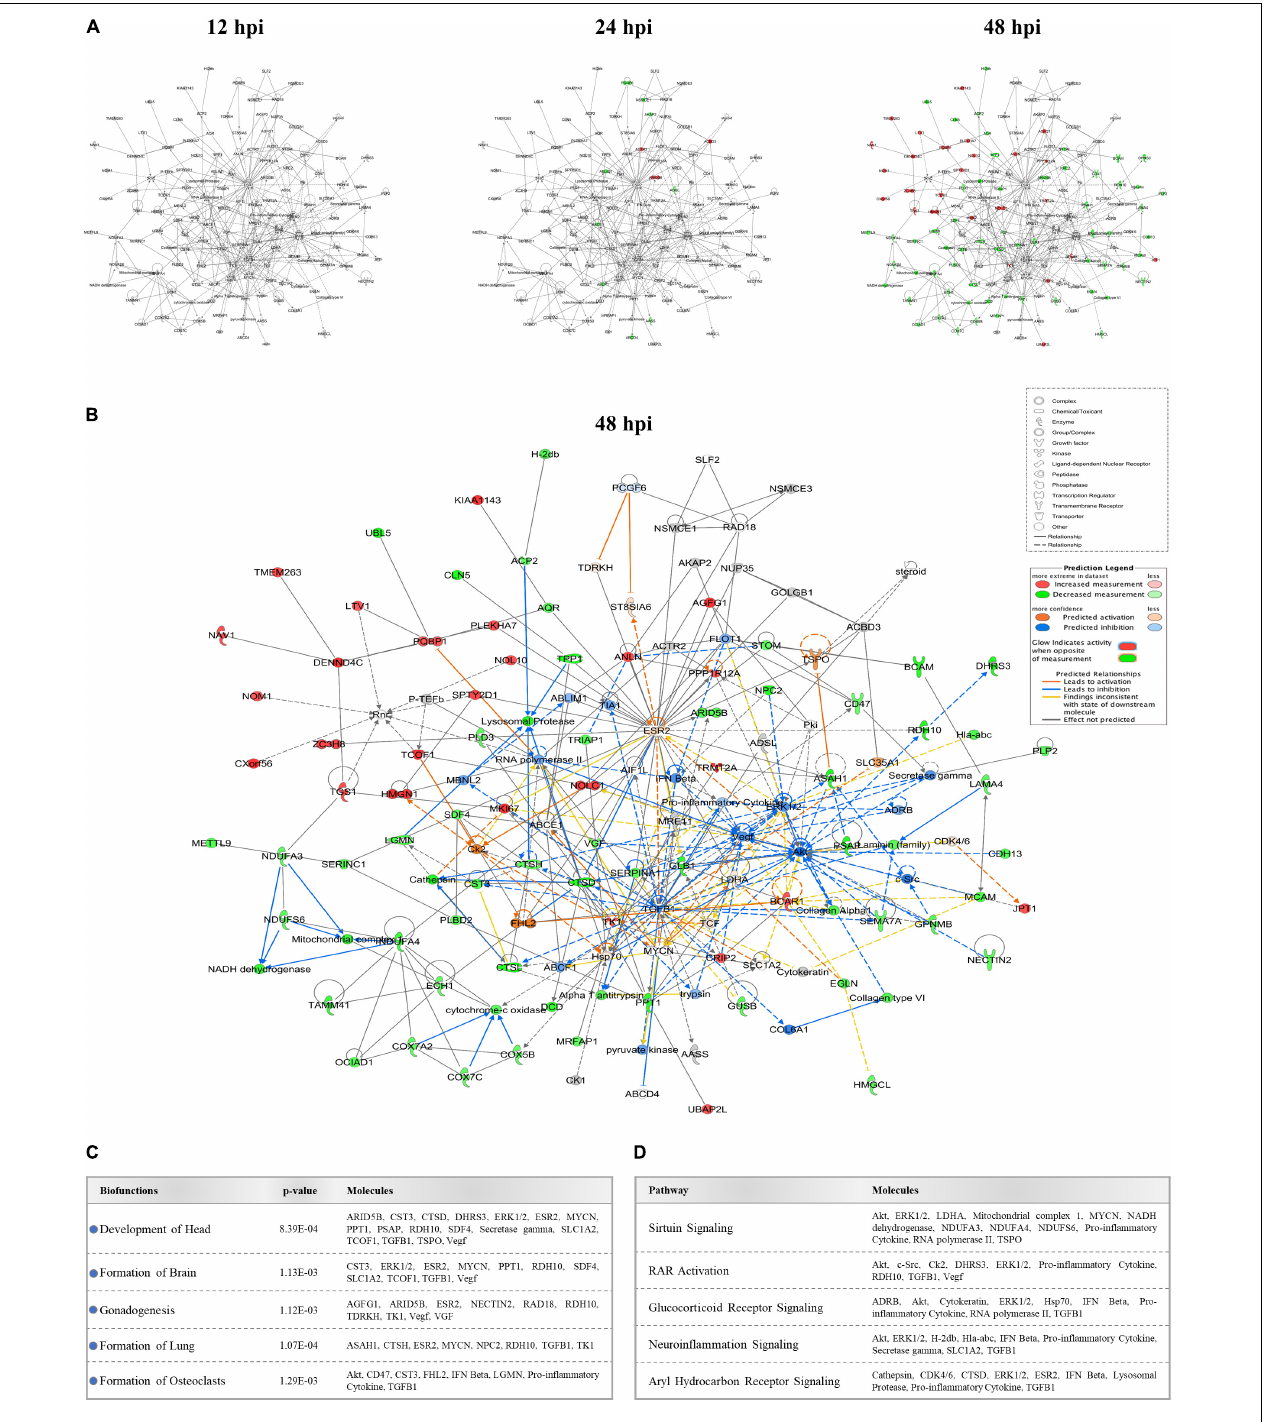
FIGURE 3 | Effect of ZIKV infection on protein-protein interaction network of developmental abnormalities. (A) Alterations in the levels of proteins controlling developmental abnormalities network across three time-points. Higher and lower ZIKV-induced protein levels are represented in red and green, respectively; gray proteins denote that they were recognized in the present study but not significantly regulated; colorless proteins interact with molecules in the network but were not identified in our study. (B) IPA prediction of the protein regulation patterns that belong to developmental abnormality interaction networks but were either not differentially expressed or identified in our study. This prediction model was established through overlaying proteomic data at 48hpi onto the merged developmental abnormality network. Molecules shown in orange and blue represent predictions for activation and inhibition, respectively. (C) Selection of specific bio-functions that were predicted to be inhibited based on ZIKV-mediated changes in molecules regulating this network. (D) List of top-affected canonical pathways that could be connected to member proteins of developmental abnormalities network.